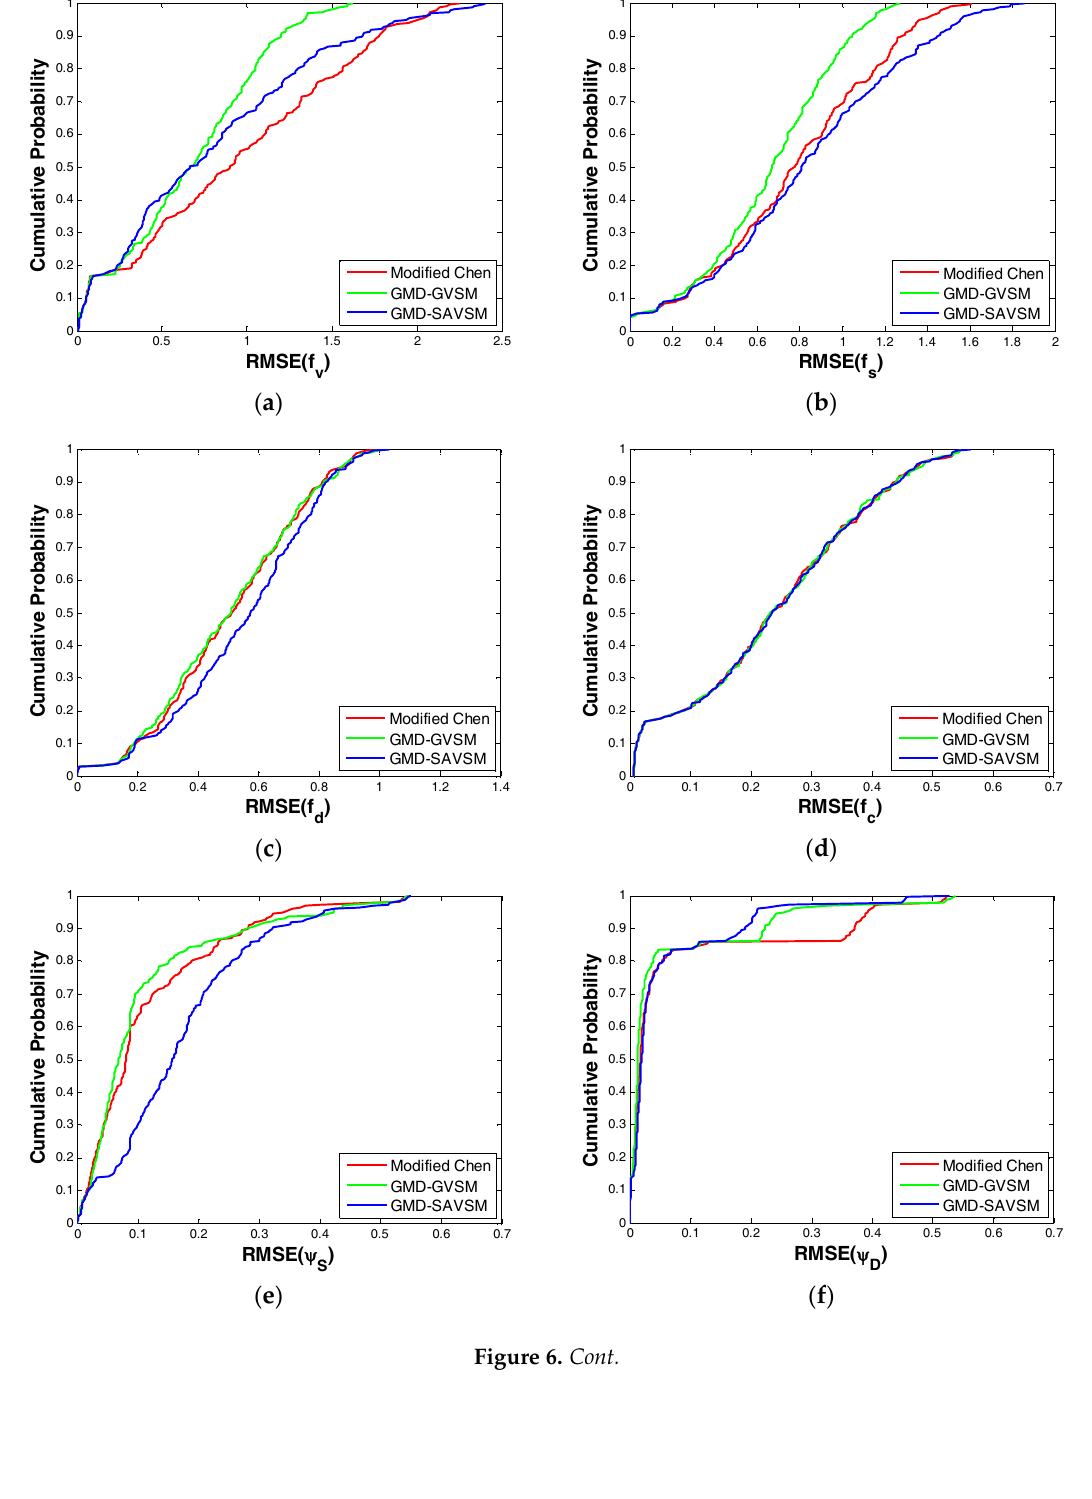
Figure 6. Cont. Figure 6.